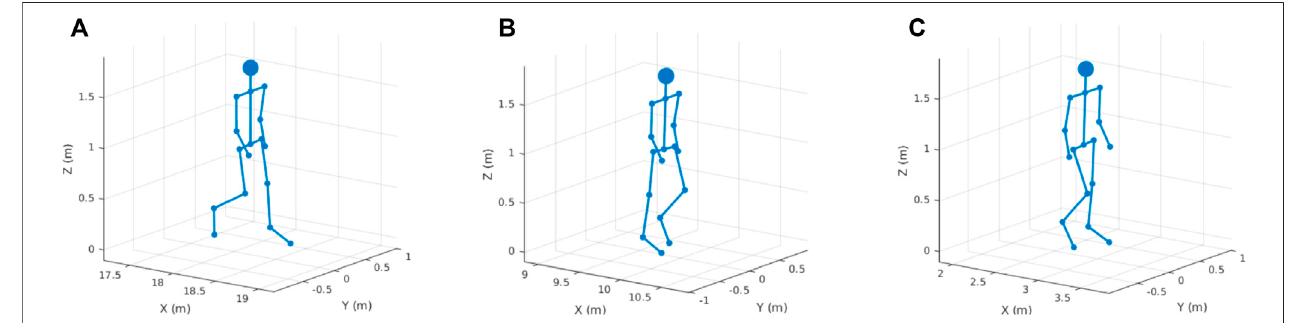
FIGURE 4 | Sixteen point-scatterers body approximation model. Sub fi gures (A – C) shows how scatterers change locations with respect to person ’ s movement.